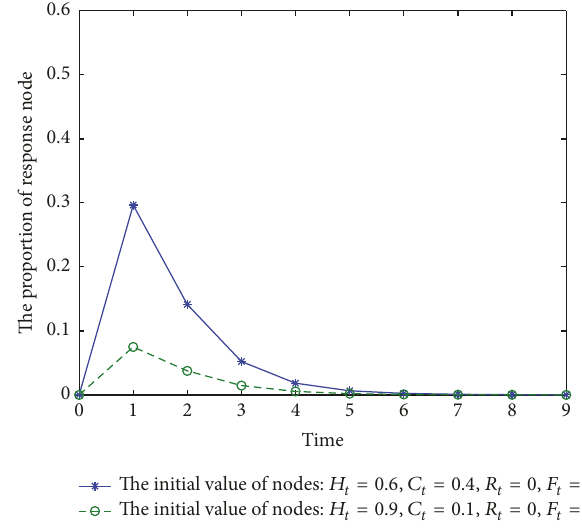
Figure 3: The proportion of healthy sensors.